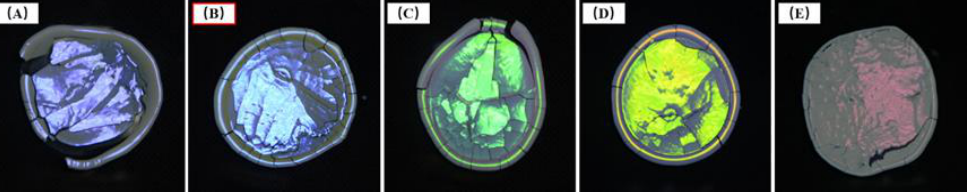
Figure 8. Photos of dried test samples of PSt microspheres synthesized with different reaction tem- perature: ( A ) 65 °C; ( B ) 70 °C; ( C ) 75 °C; ( D ) 80 °C; ( E ) 85 °C. Through single-factor experiments, combined with DLS and FE-SEM results, the ex- perimental conditions for synthesizing the most monodisperse PSt microspheres were de- termined. The polymerization time was 10 h, the initiator APS was 150 mg, the emulsifier SDBS was 175 mg, and the polymerization temperature was 70 °C. The PDI of the obtained microspheres was 0.007, the average hydrodynamic diameter was 201.4 nm, the coeffi- cient of variation was 0.021, and the average manually measured particle size was 183.3 nm.